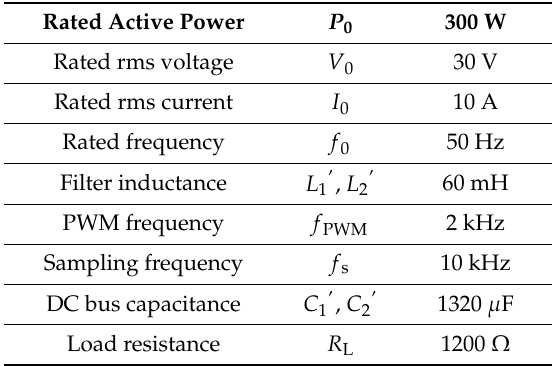
Table 3. System parameters used in the experiment.